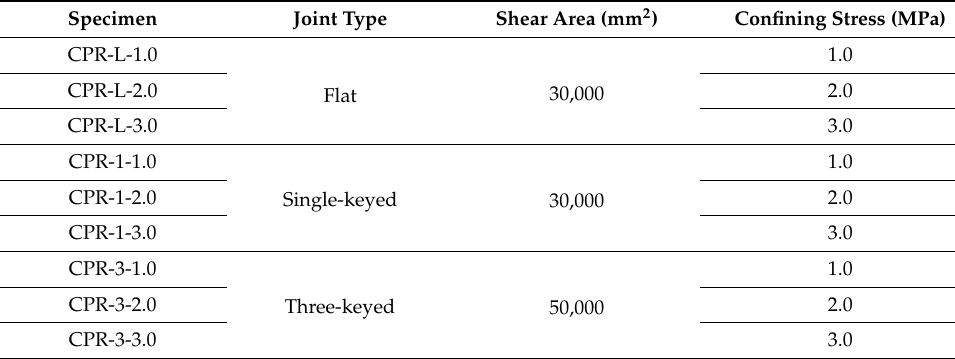
Table 6. Summary of the experimental